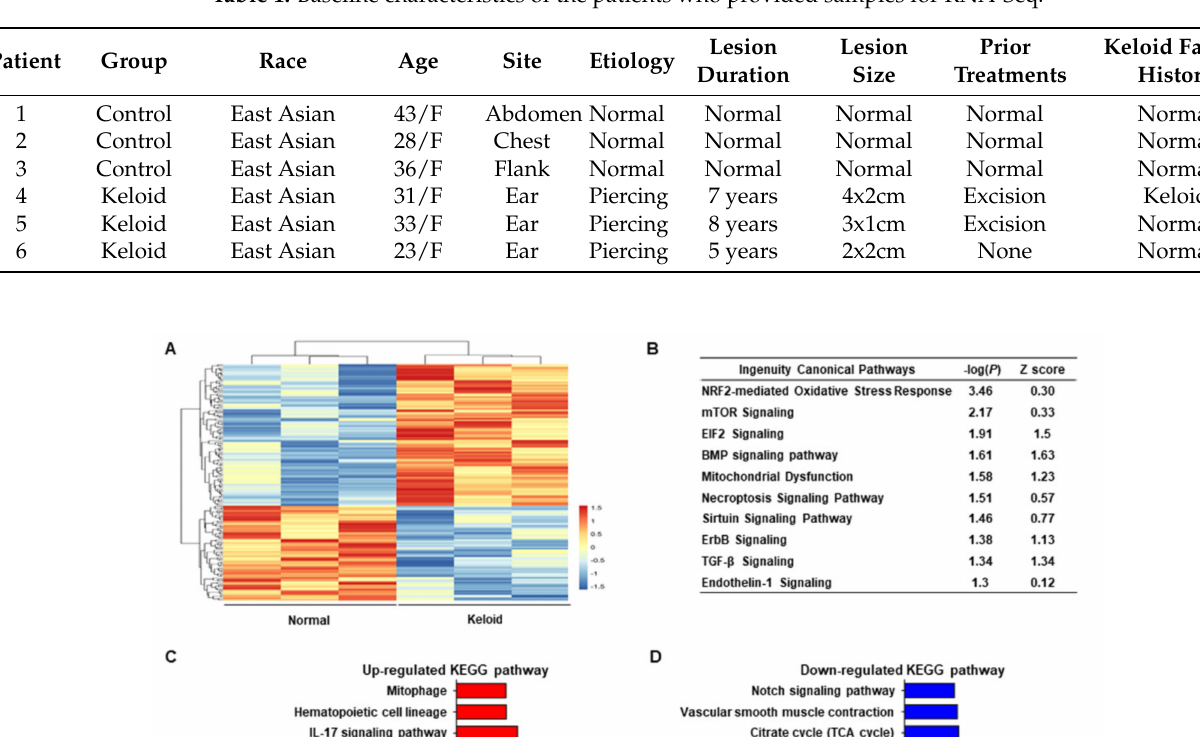
Table 1. Baseline characteristics of the patients who provided samples for RNA-Seq.